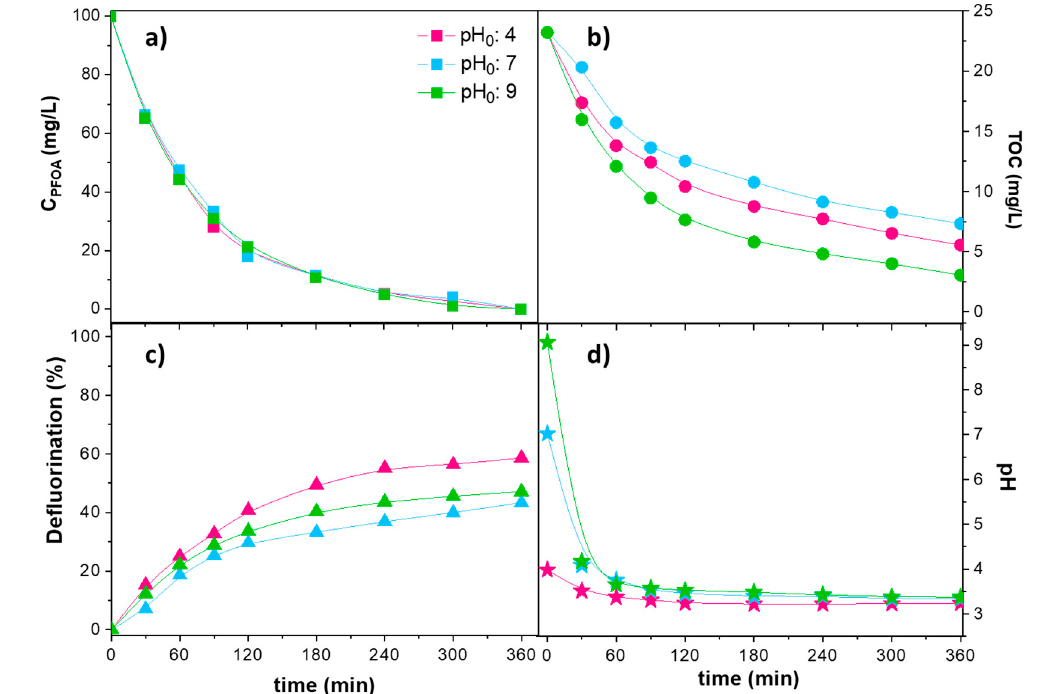
Figure 6. Influence of the pH 0 in PFOA ( a ) degradation, ( b ) mineralization, and ( c ) defluorination and ( d ) pH evolution in electrooxidation using BDD/Pt electrodes. Operating conditions: [PFOA] 0 : 100 mg/L, j: 7.9 mA/cm 2 , Na 2 SO 4 : 3.5 mM, T: 25 °C. Catalysts 2020 , 10 , x FOR PEER REVIEW